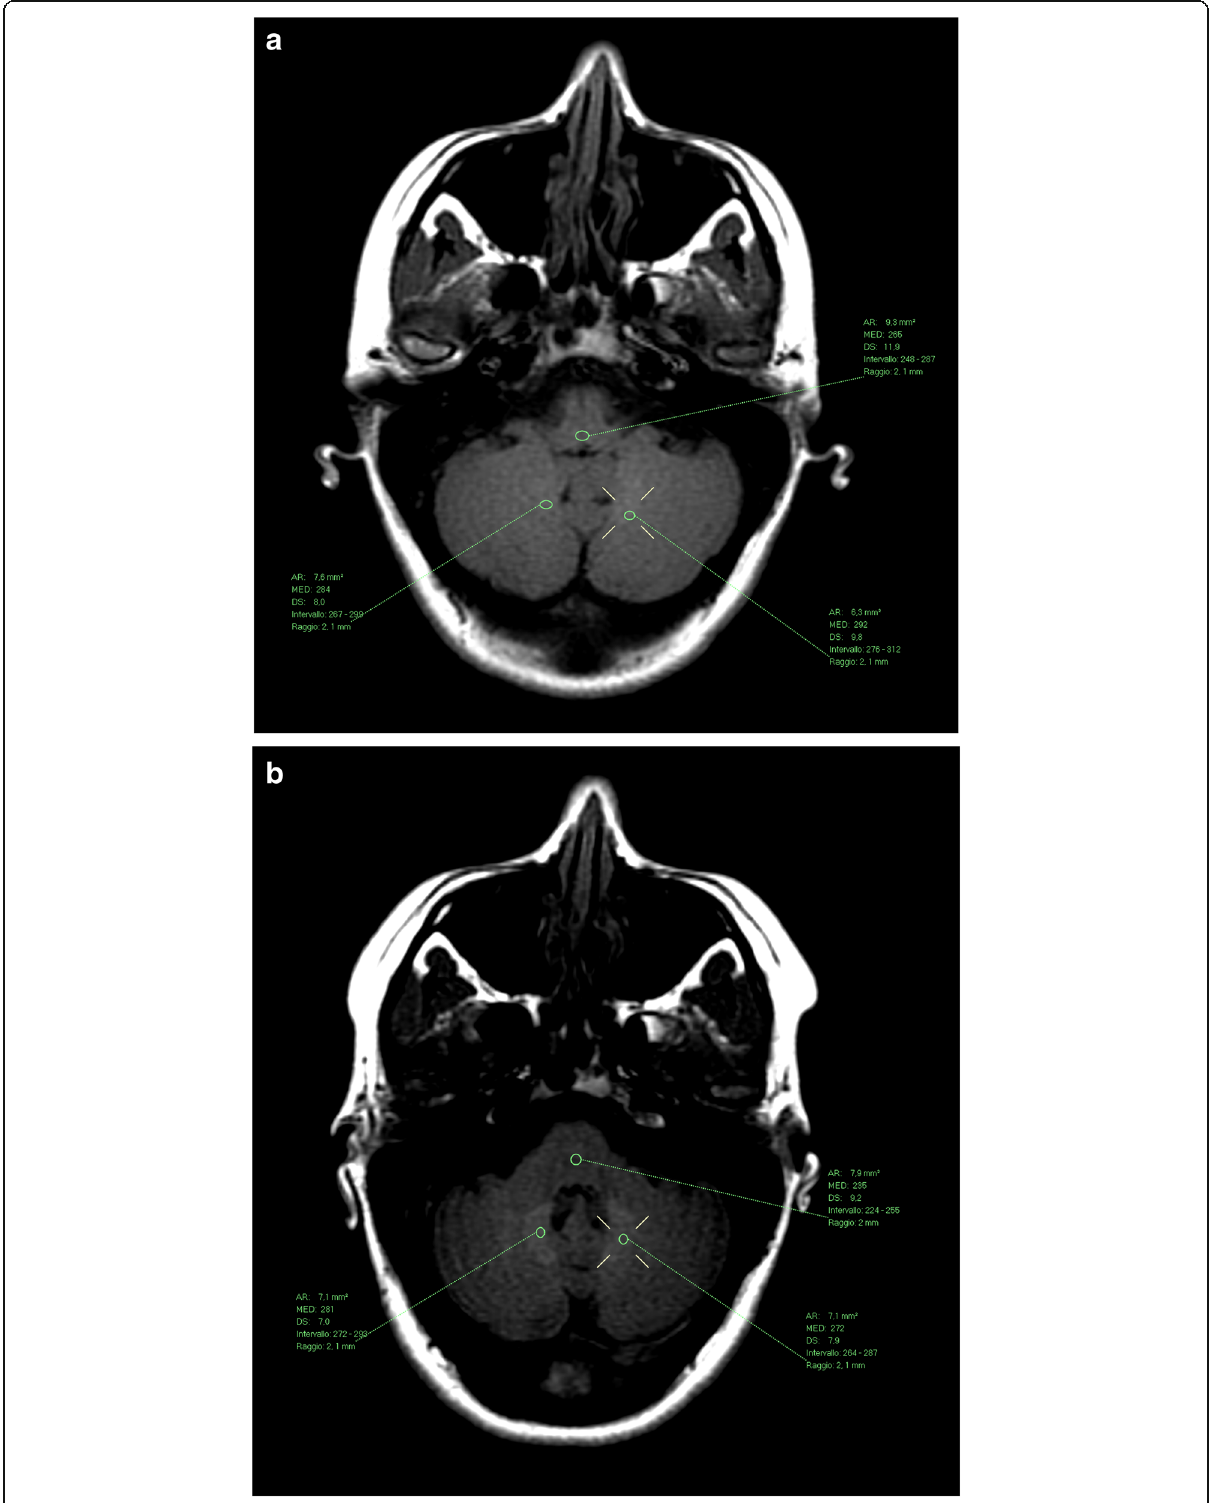
Fig. 1 Female patient, 36 years old, before ( a ) and after ( b ) seven administrations of gadoterate meglumine. The mean DN/P SI ratio on T1wSE images increased from 1.09 at the first exam in July 2006 to 1.18 at the last exam in February